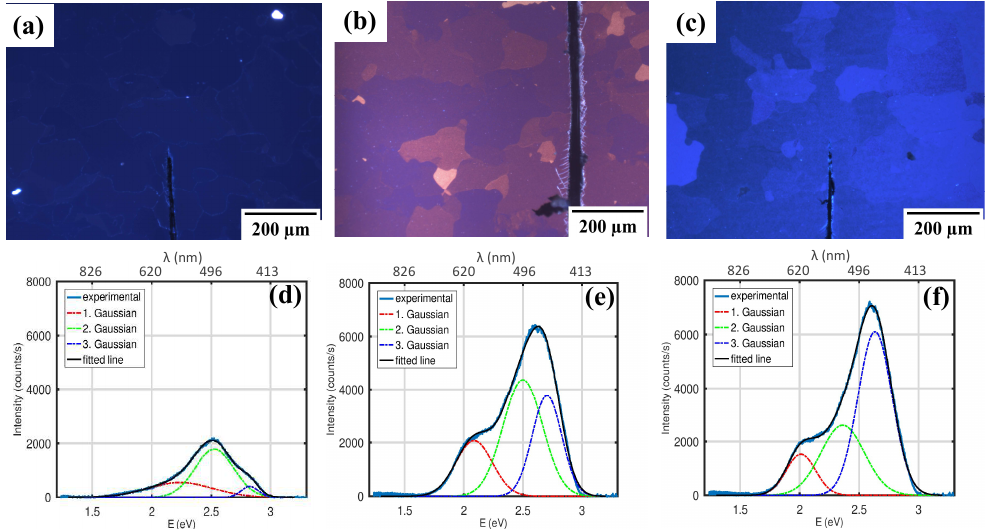
Figure 4. ( a – c ) PL microscopy images of ZnO NR–PAAO hybrid film on Al substrate from regions with different thickness ( a ) 190 nm, ( b ) 300 nm, and ( c ) 500 nm. ( d – f ) Corresponding PL spectra with decomposition in Gaussian